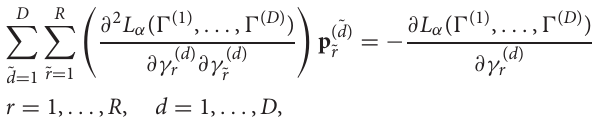
35, N 4. The plots show the absolute error = =